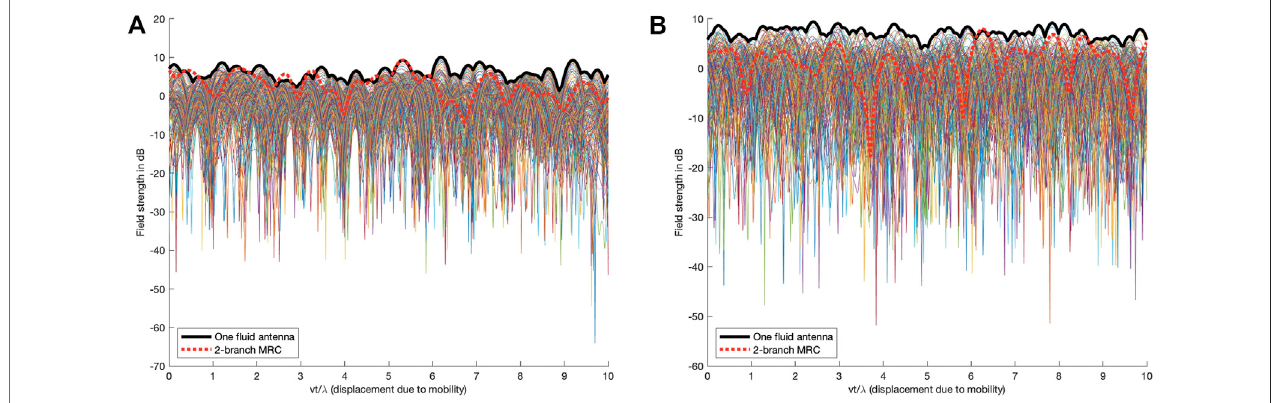
FIGURE7| ExamplesoffadingenvelopesforUEtravellingat30 km/hat3 GHzwhenthe fl uidantennahas200portsandaone-dimensionalspaceof (A) 5 λ or (B) 20 λ